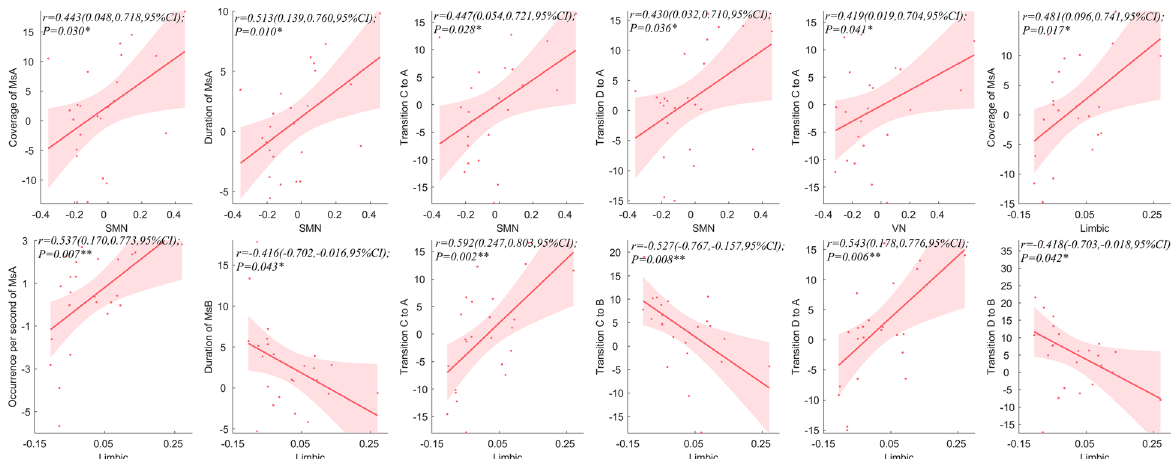
Fig.7 The correlation between Intra- and Internetwork FC and microstate parameters of patient group. A . The correlation between SMN and coverage of MsA. B . The correlation between SMN and duration of MsA. C . The correlation between SMN and transition probability from MsC to MsA. D . The correlation between SMN and transition probability from MsD to MsA. E . The correlation between VN and transition probability from MsC to MsA. F . The correlation between limbic and coverage of MsA. G . The correlation between limbic network and occurrence per second of MsA. H. The correlation between limbic network and duration of MsB. I. The correlation between limbic network and transition probability from MsC to MsA. J. The correlation between limbic network and transition probability from MsC to MsB. K. The correlation between limbic network and transition probability from MsD to MsA. L. The correlation between limbic and transition probability from MsD to MsB. The correlation was analyzed by the residuals of intra-network connection and inter-network connection time series and microstate parameters with age, sex and FD as covariates. Ms, microstate; SMN, sensory-motor network; VN, visual network, CI, confidence intervals; * P <